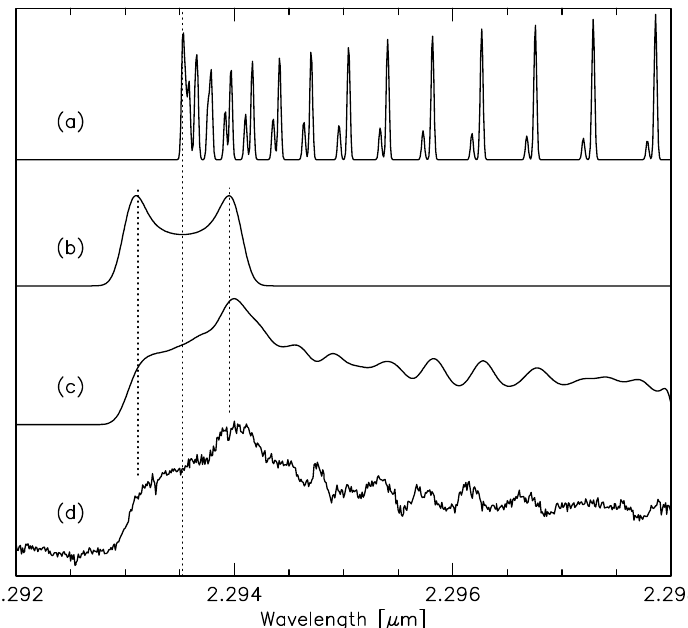
Figure 2. Sketch of the generation of the typical CO band head profile. ( a ) Spectrum around the (2-0) band head of the CO first-overtone bands for a hot gas with velocity dispersion of a few kms − 1 . ( b ) Profile of a single line from a rotating gas ring with a velocity, projected to the line of sight, of 66kms − 1 as seen with a spectral resolution of 6kms − 1 . ( c ) Total synthetic CO band head spectrum resulting from the convolution of the band transitions in ( a ) with the profile of the ring in ( b ). ( d ) CO band head observations of the Galactic B[e]SG CPD-572874